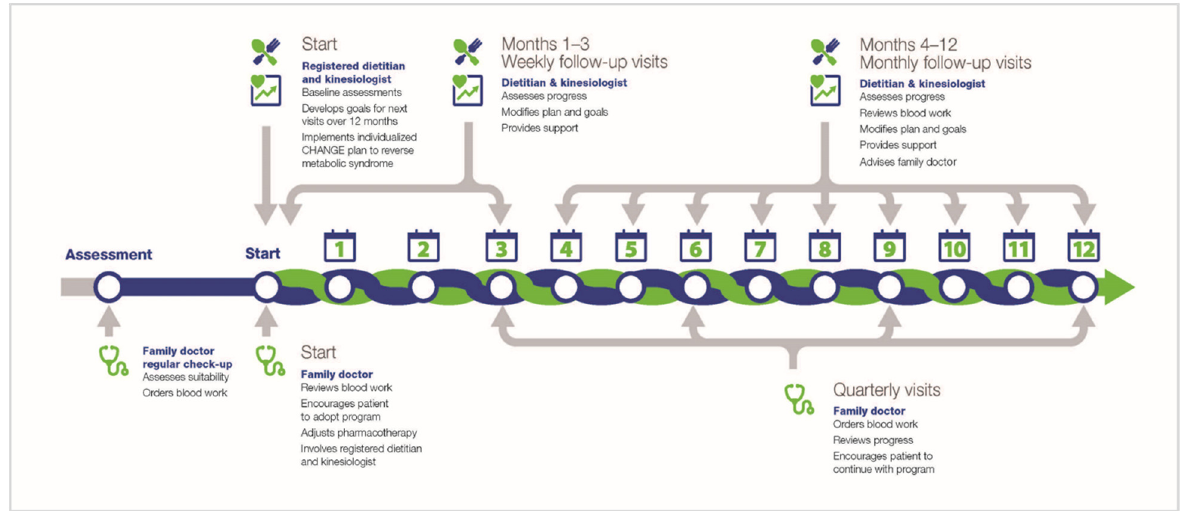
Figure 1. Data collection plan for lifestyle intervention study.